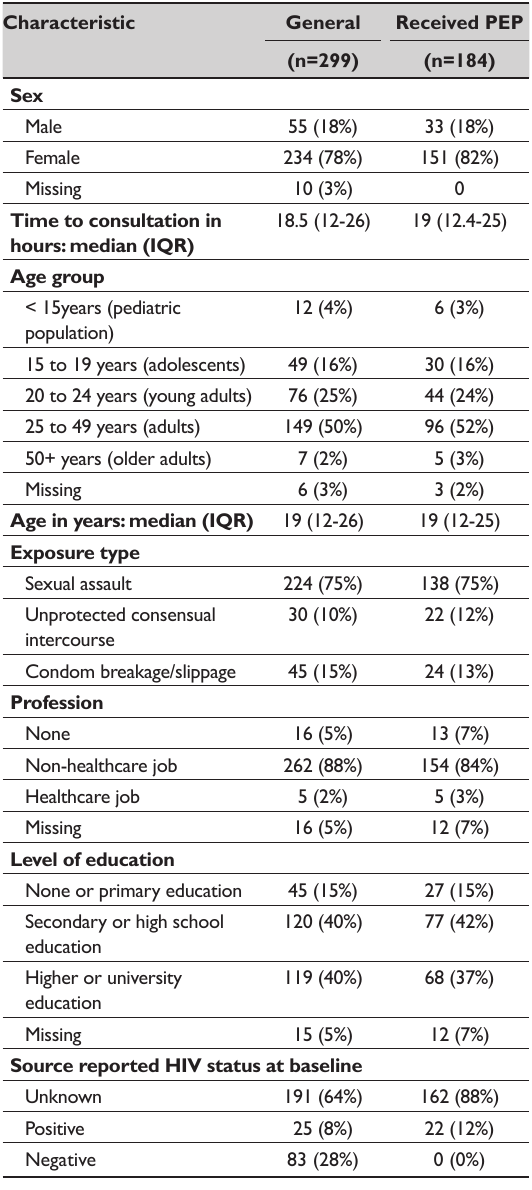
Table 2: Characteristics of individuals seen at Yaounde Central Hospital for non-occupational post-exposure